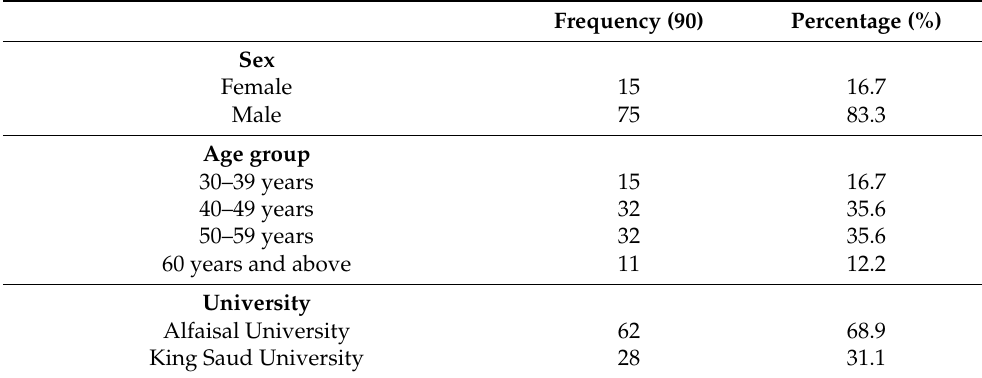
Table 5. Descriptive analysis of the faculty’s demographic and professional